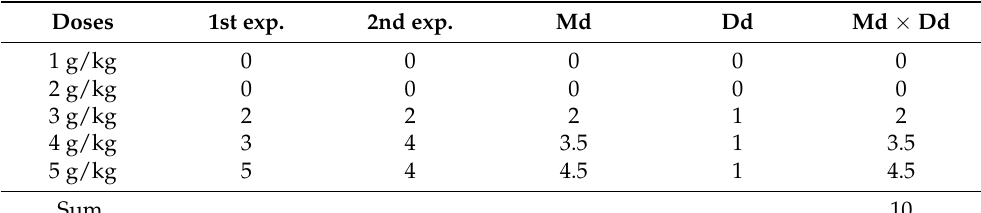
Md: mean death; Dd: dose difference.